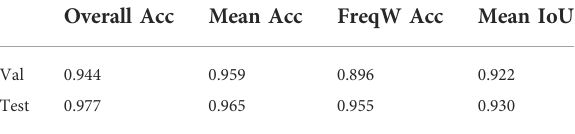
TABLE 1 Semantic segmentation network performance on the validation (AirSim) and test set (Gazebo). Overall Acc